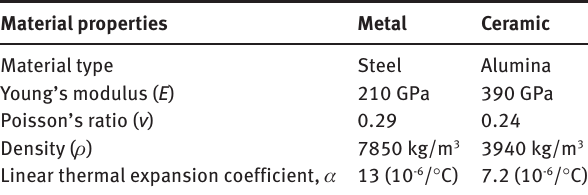
Table 2 Material properties of the FGM